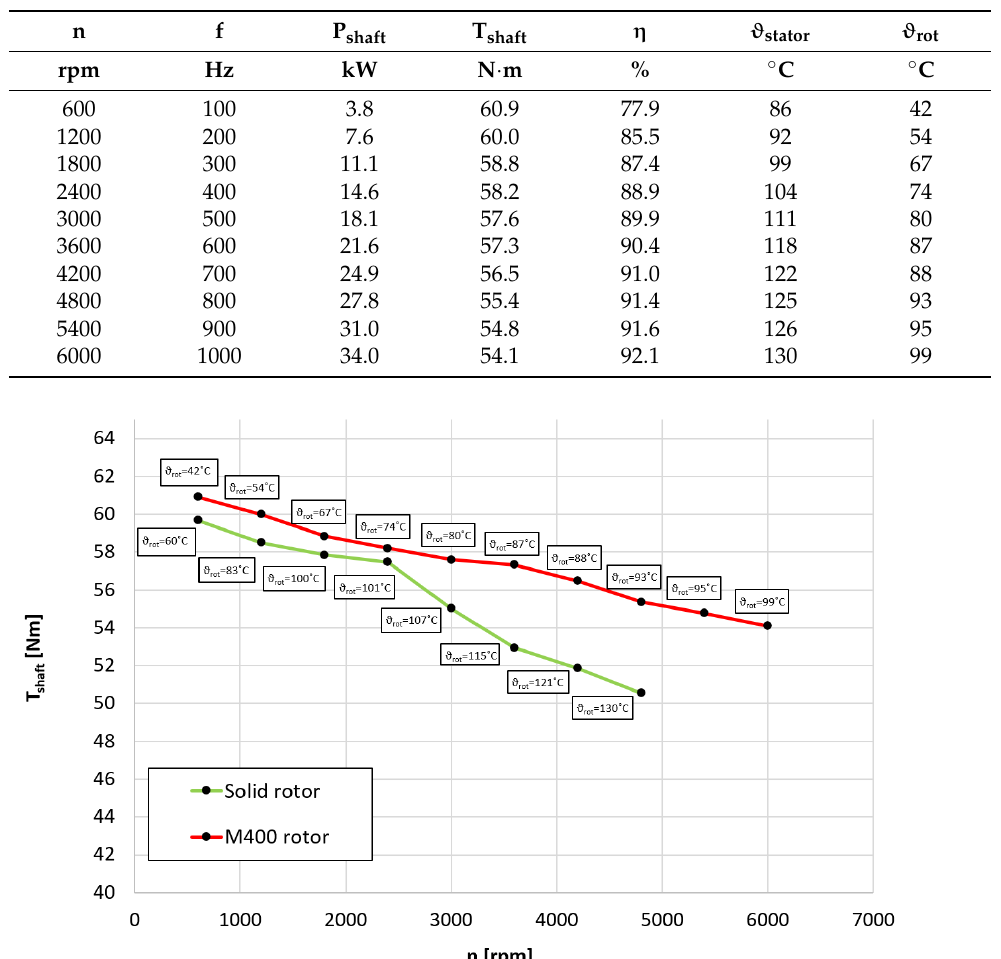
Table 6. The results of tests bench for a model motor with laminated M400 rotor for the rated load current I N .